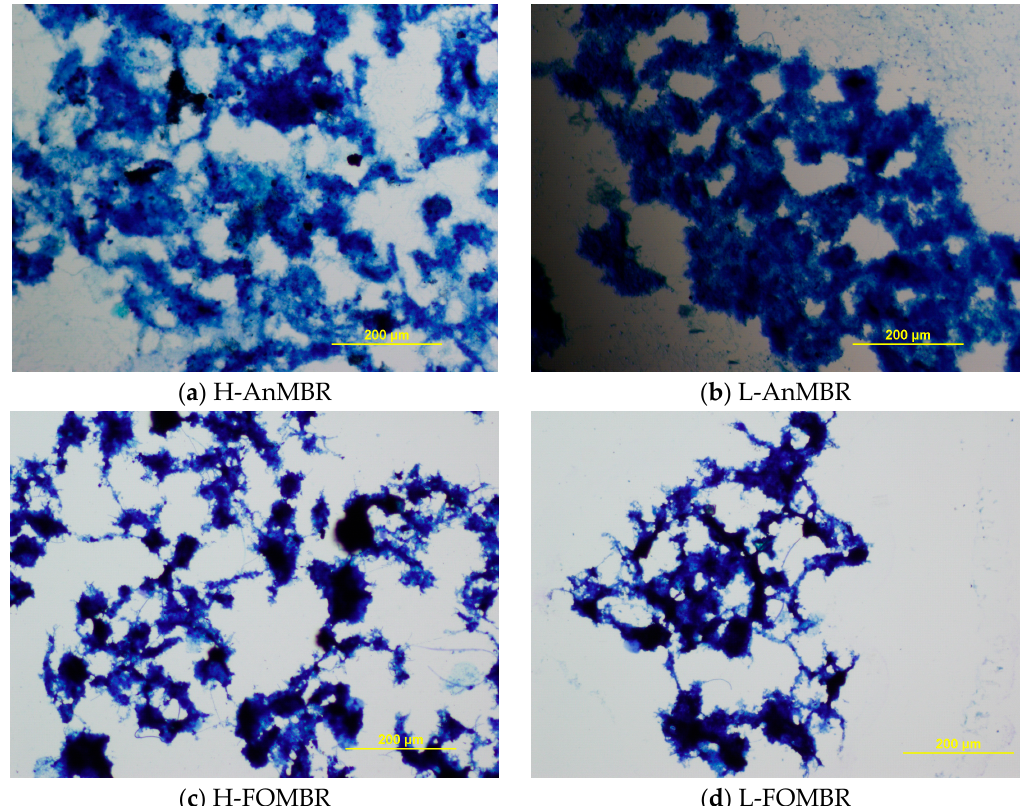
Figure 6. Photos of activated sludge flocs from the ( a ) H-AnMBR and ( b ) L-AnMBR and the ( c ) H-FOMBR and ( d ) L-FOMBR.